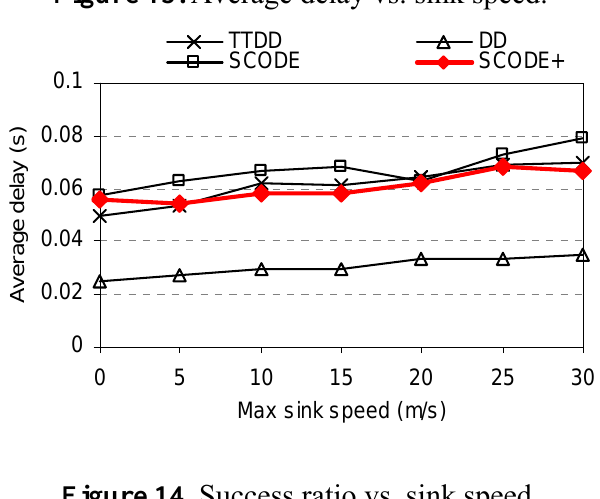
Figure 14. Success ratio vs. sink speed.